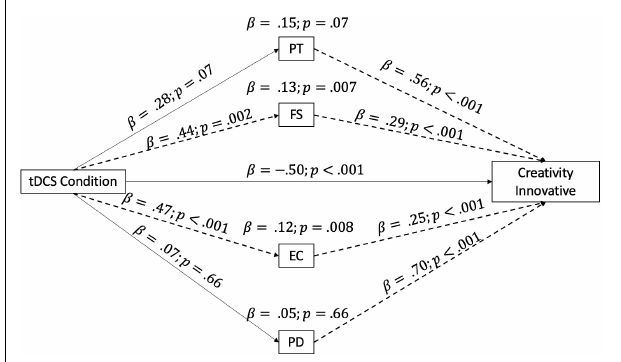
FIGURE 1 | Mediation model taking into consideration the IRI subscales as mediators of the relationship between the tDCS condition and the evaluation of creativity/innovation. The arrow indicates the direction of the mediation, and the dotted lines highlight significant mediation effects. IRI subscales: PT, perspective taking; FS, fantasy; EC, empathic concern; PD, personal distress.